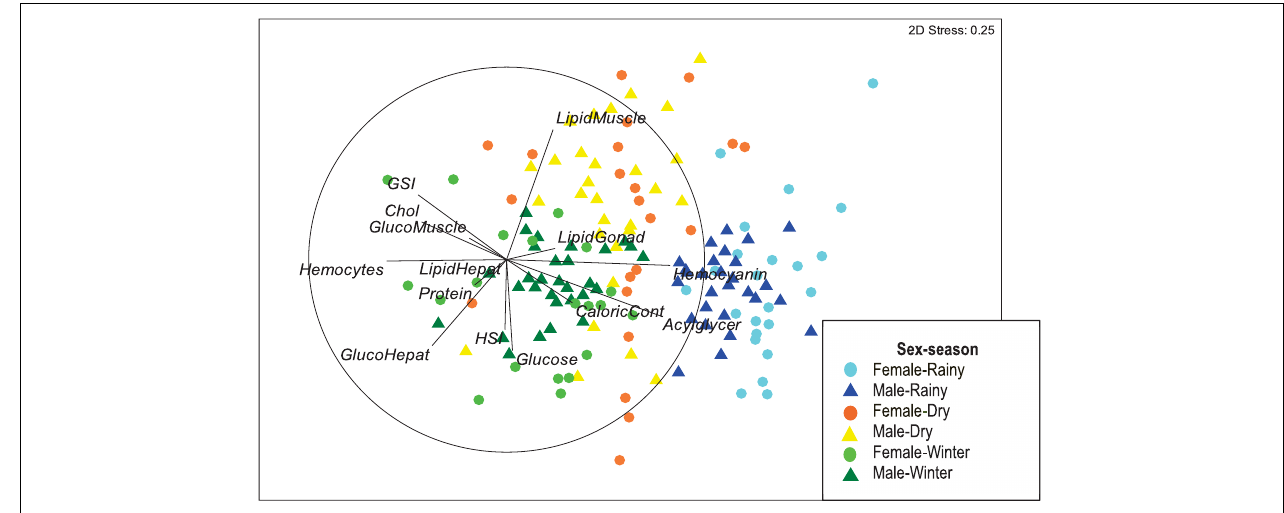
FIGURE 1 | Non-metric Multidimensional Scaling (NMDS) of 14 descriptors biochemical composition: hemolymph (hemocyanin, hemocyte concentration, total protein, glucose, cholesterol and acylglycerides), gonads, hepatopancreas and muscle (glycogen concentration and total lipids), caloric value of muscle, hepatosomatic index (HSI) and gonadosomatic index (GSI) in Octopus maya caught in three seasons (winter, dry, and rainy season).